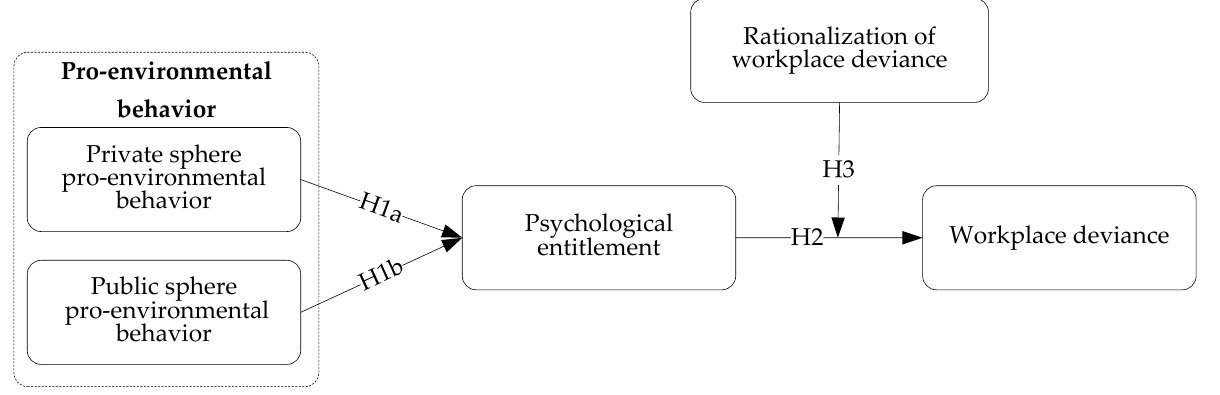
Figure 1. Conceptual model.